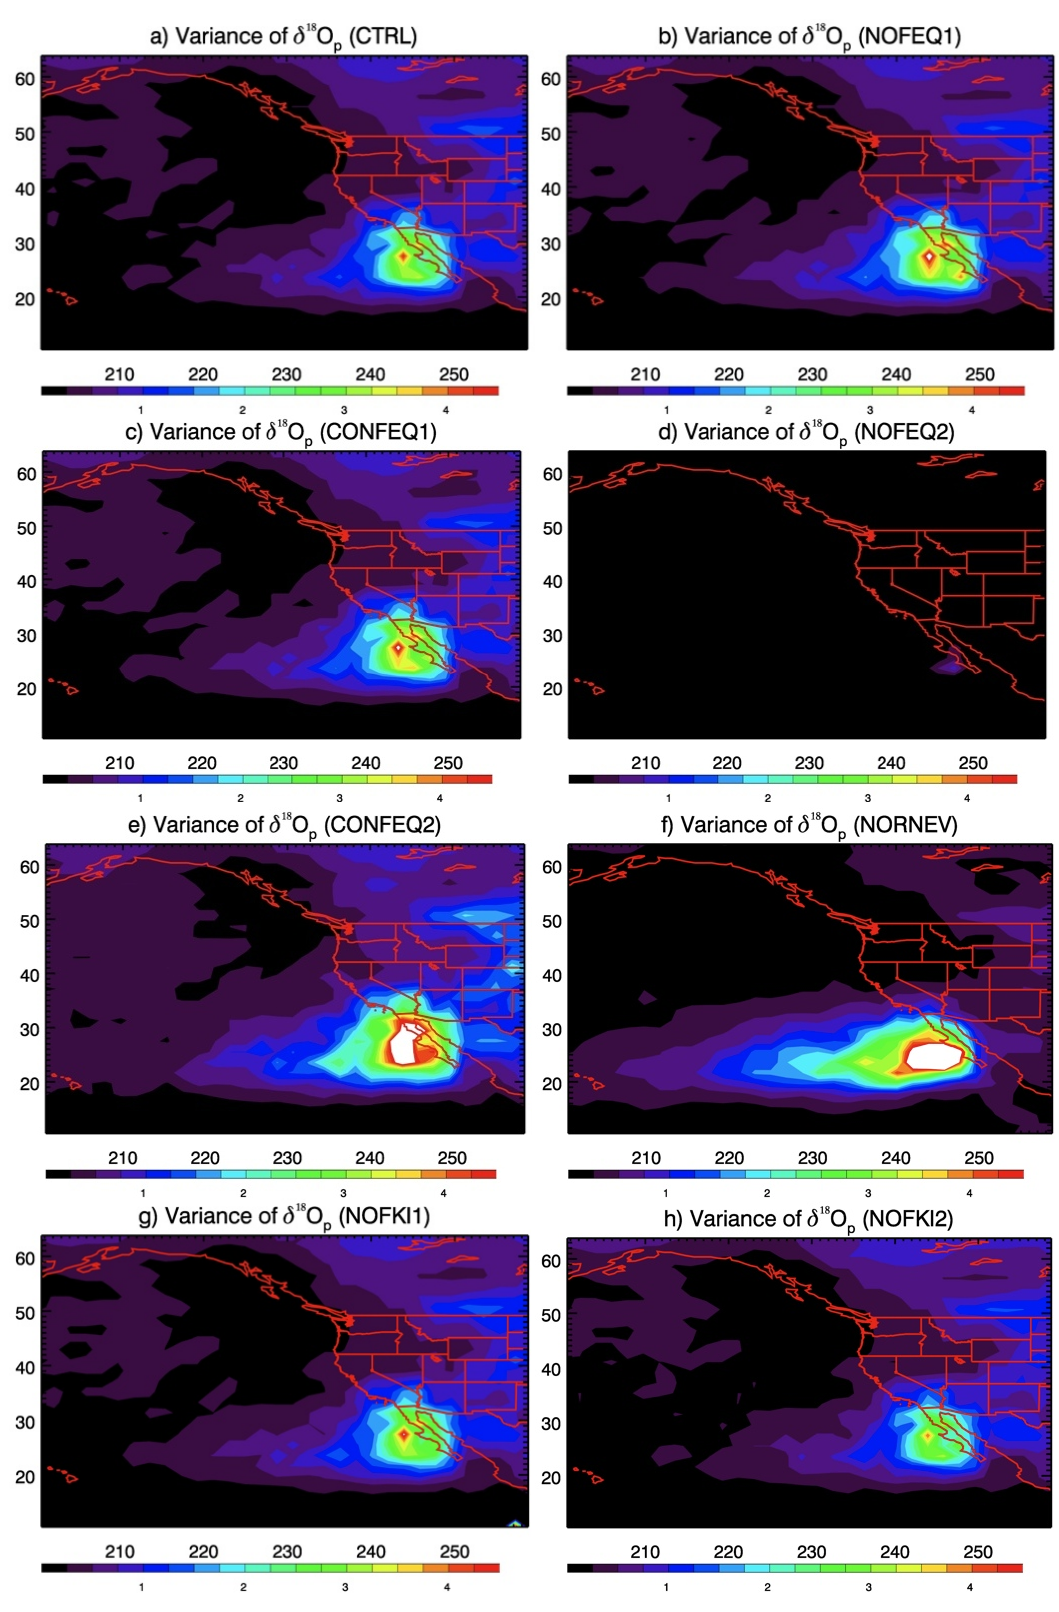
Figure 1. ( a ) Spatial distribution of variance of δ 18 O ( b )–( h ) 7 model experiments. Variance is calculated from interannual time series at each grid cell. Contour intervals are